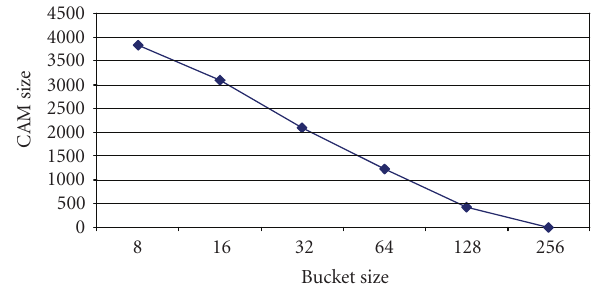
Figure 10: CAM size required to accommodate rules moved to CAM.